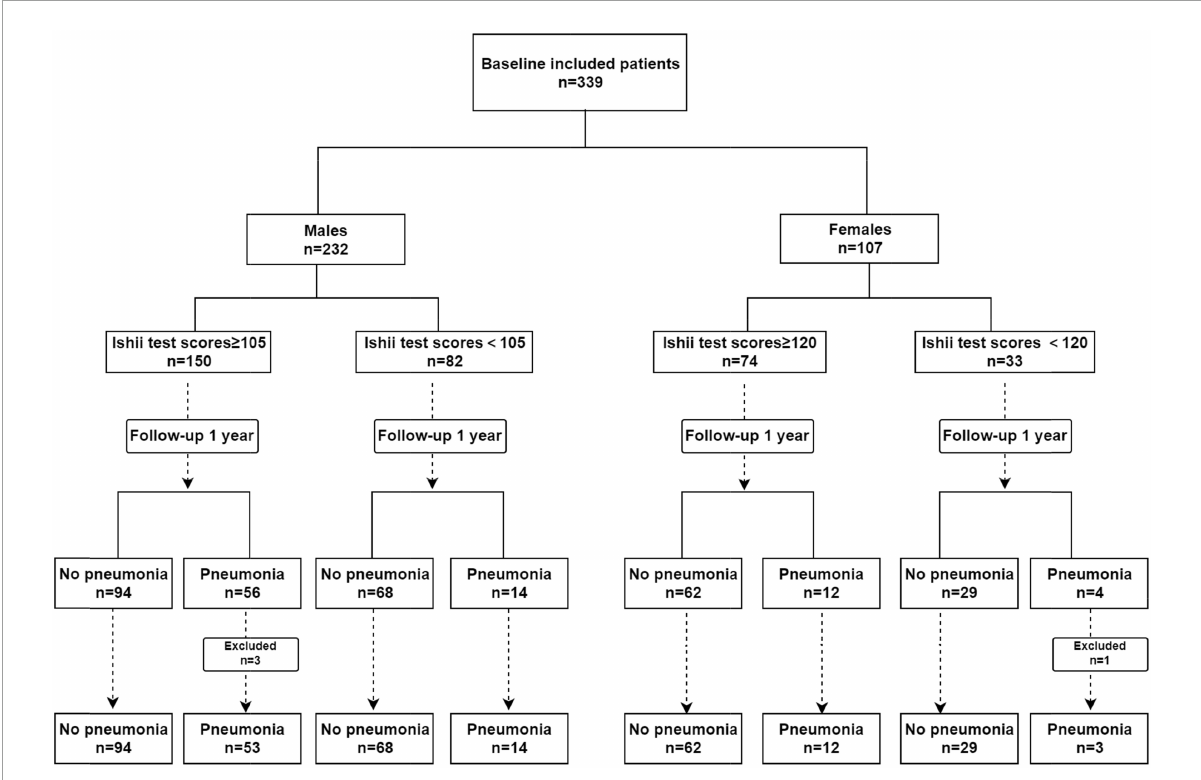
FIGURE1 The study profile included patient selection and pneumonia